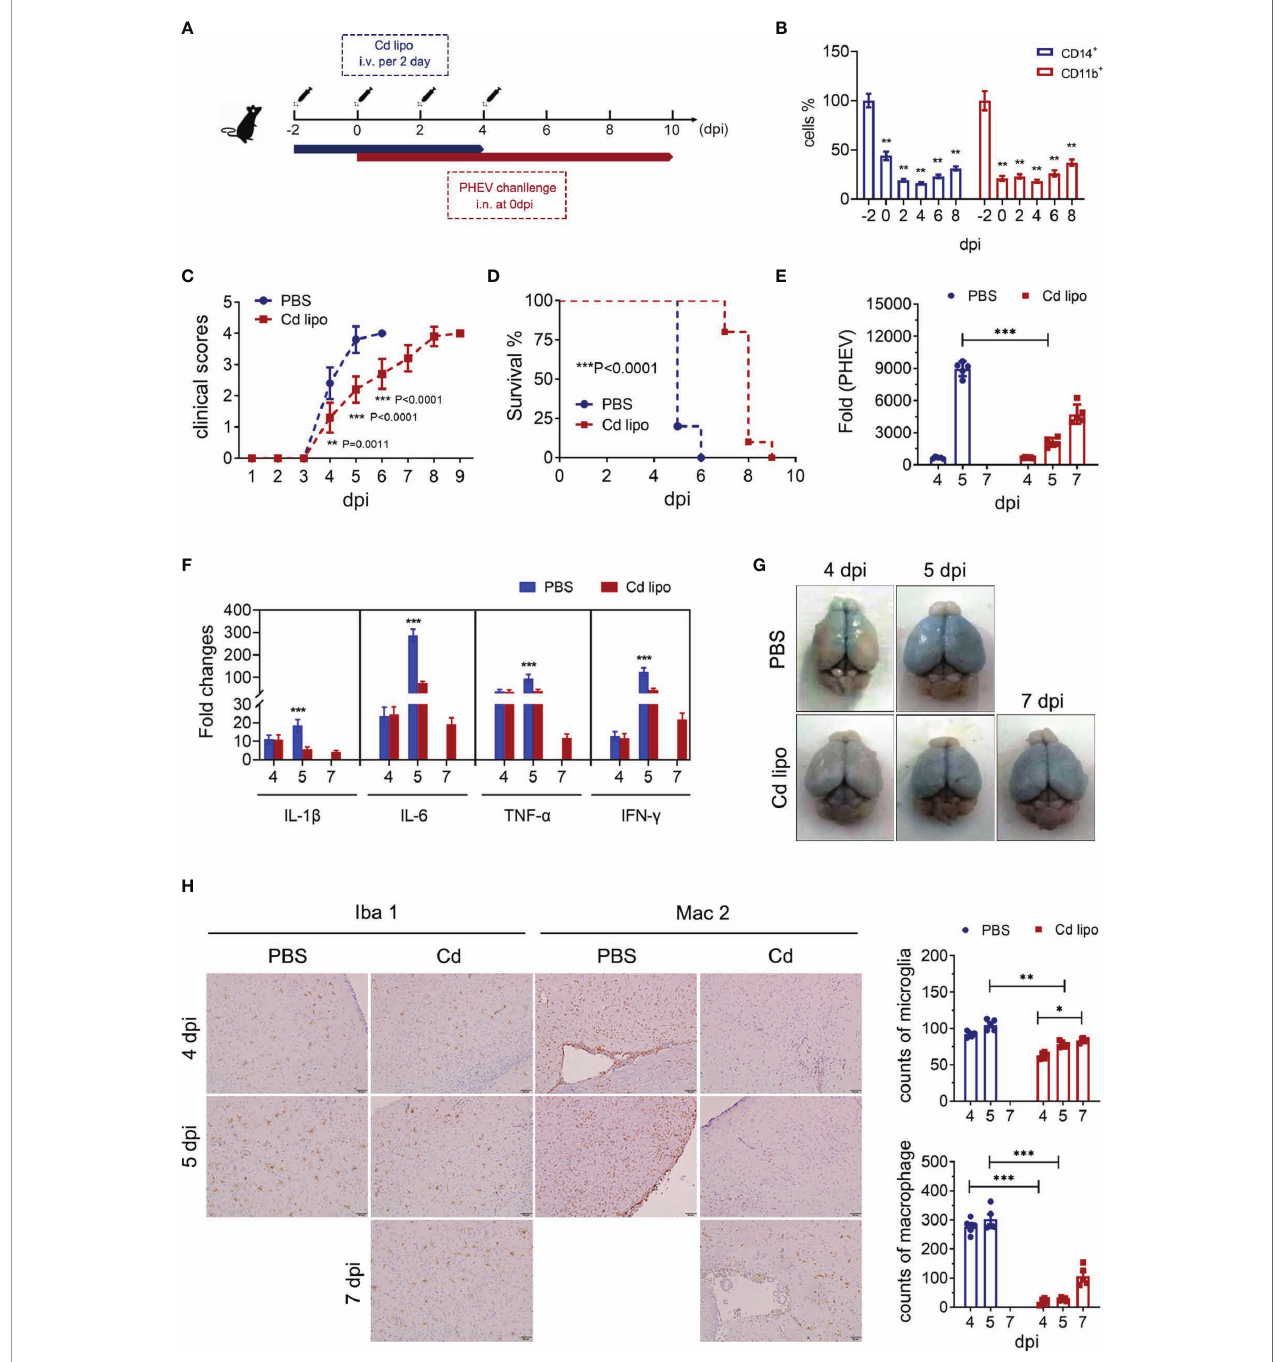
FIGURE 5 | Macrophage depletion reduces microglial activation in late infection of PHEV. (A) Procedure of Cd lipos administration and PHEV infection. (B) The effect of Cd lipos on peripheral monocytes/macrophages was evaluated using fl ow cytometry. (C) Clinical scores. (D) Survival curves. (E) Viral replication in the brain was measured using qRT – PCR at 4, 5, and 7 dpi. (F) The expression of in fl ammatory cytokines, including IL-1 b , IL-6, TNF- a , and IFN- g , was evaluated at 4, 5, and 7 dpi using qRT – PCR. (G) BBB destruction in mice was evaluated by i.v. injecting EB at 4, 5, 7 dpi. (H) Morphological changes and microglial counts were analyzed at 4, 5, and 7 dpi. Microglia and peripheral monocytes/macrophages were labeled with antibodies against Iba 1 and Mac 2, respectively. Each column represents the mean ± SD of 5 fi elds per group (200×). Student ’ s t test (*, P <0.05; **, P<0.01; ***,